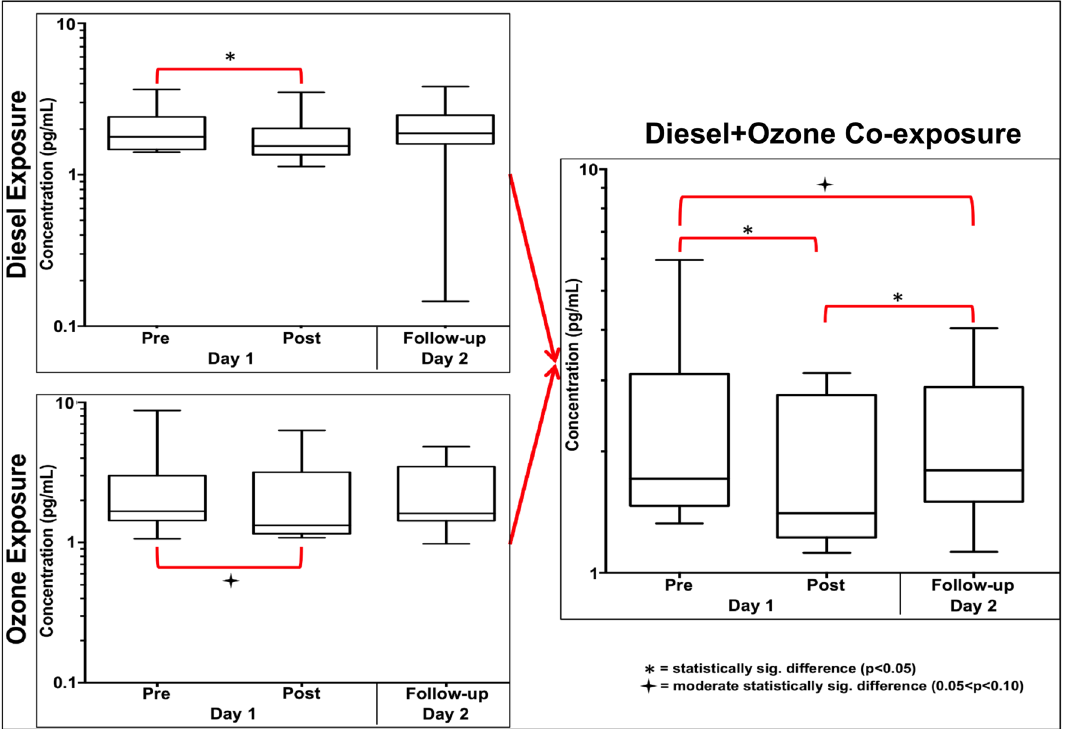
Fig 5. TNF- α cytokine results for three exposure scenarios. The boxes in Fig 5, above, display the median, upper 75%, and lower 25% of the concentrations for TNF- α , while the bars display the upper 97.5% and the lower 2.5% of the concentrations. This figure shows that the combination of the DE- only and O 3 -only exposures into a DE+O 3 co-exposure creates a suppression of TNF- α that does not recover after a 22-hour